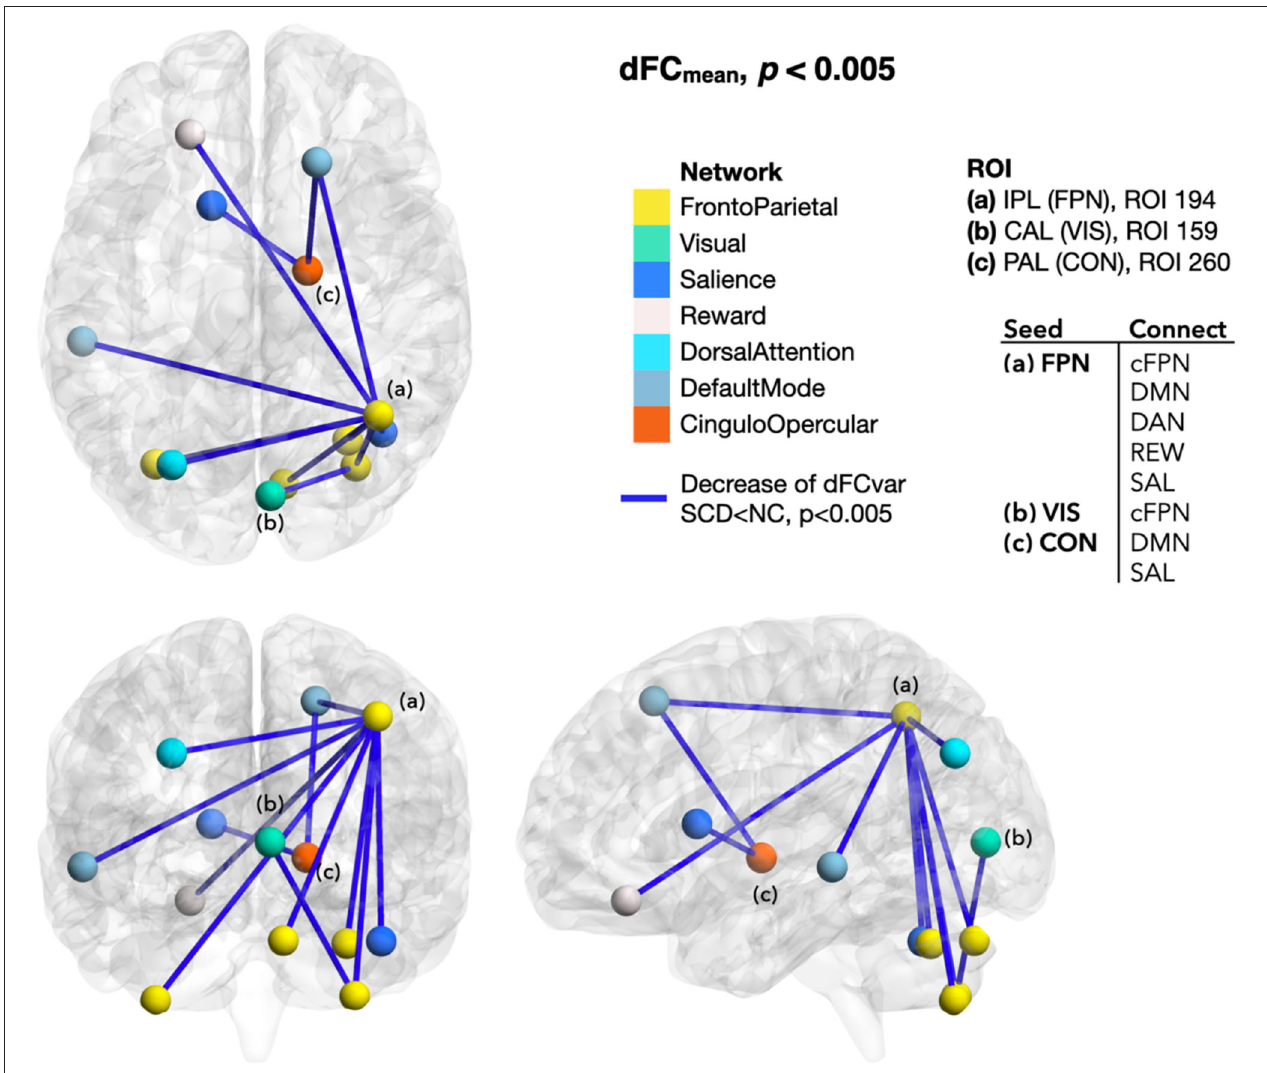
FIGURE 4 | Differences of dFC mean between SCD and NC. The dFC mean seeded from the ROIs with local mdALFF group differences generally decreased in SCD than NC, including the dFC from the FPN ROI to the cFPN, DMN, DAN, REW, and SAL ROIs ( p < 0.005). Color of line indicated the changes of dFC. Blue was for decrease. Color of ROIs represented the functional network they belonged to. dFC mean , mean of the dynamic functional connectivity; SCD, subjective cognitive decline; NC, normal control; ROI, region of interest; IPL, inferior parietal lobule; FPN, frontoparietal network; CAL, calcarine area; VIS, visual network; PAL, pallidum of lenticular nucleus; CON, cingulo-opercular network; cFPN, frontoparietal network in the cerebellar regions; DMN, default mode network; DAN, dorsal attention network; REW, reward network; SAL, salience